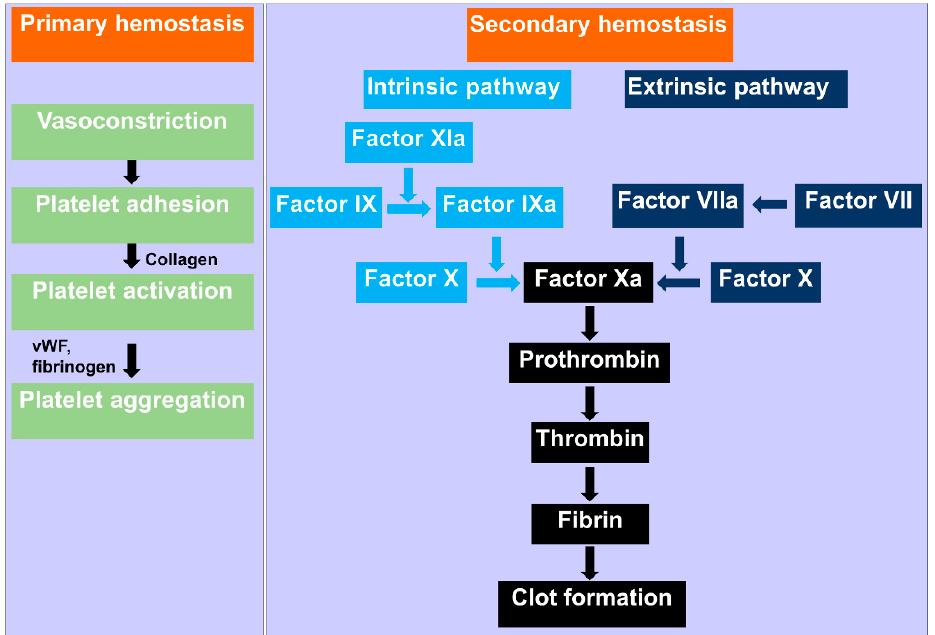
Figure 1. Schematic mechanism of hemostasis. Primary hemostasis starts with vasoconstriction at the injury site, and platelet aggregates due to the interaction of fibrinogen and Willebrand factor (vWF). Secondary hemostasis involves the formation of insoluble, cross-linked fibrin via stimulated coagulation factors, especially thrombin.